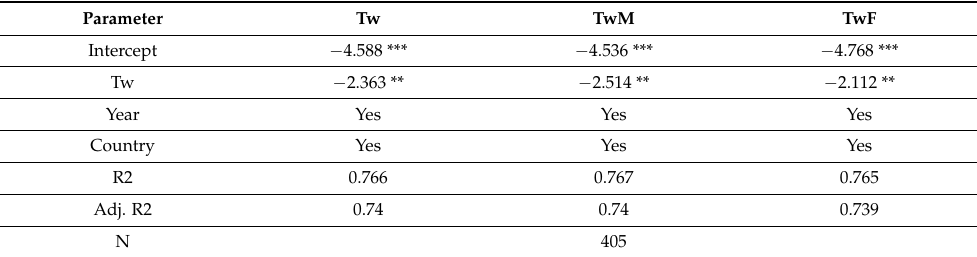
** and *** represent levels of significance of 5% and respectively